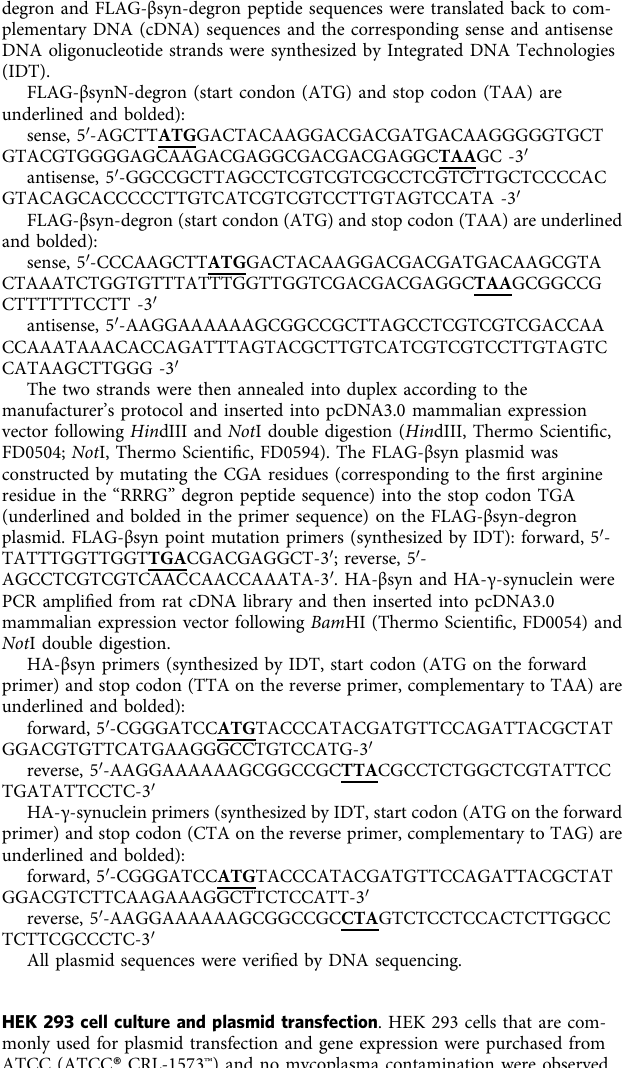
Fig. 4 Tat- β syn-degron peptide protects against parkinsonian toxin-induced neuronal damage in rat ventral midbrain cultures. Immunoblotting ( a – c ) and immunocytochemical staining ( d ) followed by blinded TH-positive neuron counting ( e ) showing that bath application (25 µ M; 48 h) of Tat- β syn- degron, but not Tat- β syn, signi fi cantly reduced the level of endogenous α -synuclein ( a , b ; N = 8; F (3,21) = 18.39, P < 0.001; Bonferroni post hoc test: MPP + + Tat- β syn-degron vs. MPP + : ### P < 0.001), and prevented MPP + (20 µ M; 48 h)-induced TH-positive neuronal damage as demonstrated by the loss of TH protein ( a , c ; N = 8; F (3,21) = 6.87, P < 0.01; Bonferroni post hoc test: MPP ++ Tat- β syn-degron vs. MPP + : ## P < 0.01) and by the decreased numbers of TH-positive neurons ( e ; N = 8; F (3,21) = 38.00, P < 0.001; Bonferroni post hoc test: MPP ++ Tat- β syn-degron vs. MPP + : ### P < 0.001). d Representative TH-positive neuron staining. Data are presented as mean ± SEM. The statistical difference between groups was determined by two-way ANOVA, followed by Bonferroni post hoc test. ** P ≤ 0.01 and *** P ≤ 0.001 compared with the control. ## P ≤ 0.01 and ### P ≤ 0.001 indicate the statistical difference between the MPP ++ peptide group and the MPP + group. n.s. denotes not signi fi cant. Scale bar in d : 50 µ m. Solid circles, squares and